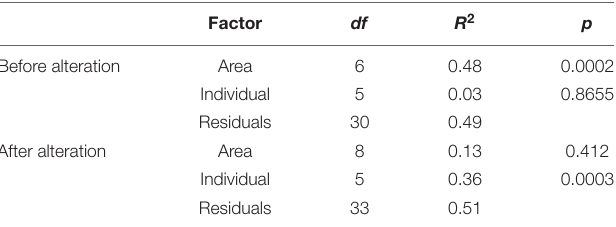
TABLE 4 | Permutational multivariate analysis of variance results for the assemblage of the 10 action categories observed during play [ R 2 (coefficient of determination) indicates how well each factor explains the dependent variable].